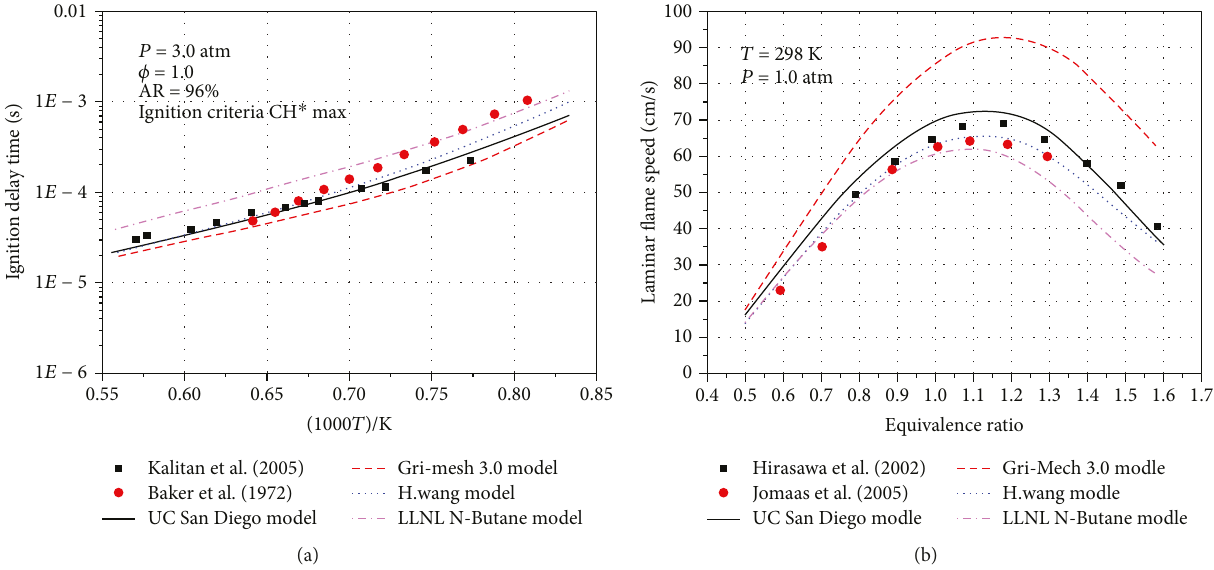
Figure 3: Comparison of calculated values versus experimental results, in which (a) ignition delay time and (b) fl ame propagation speed.